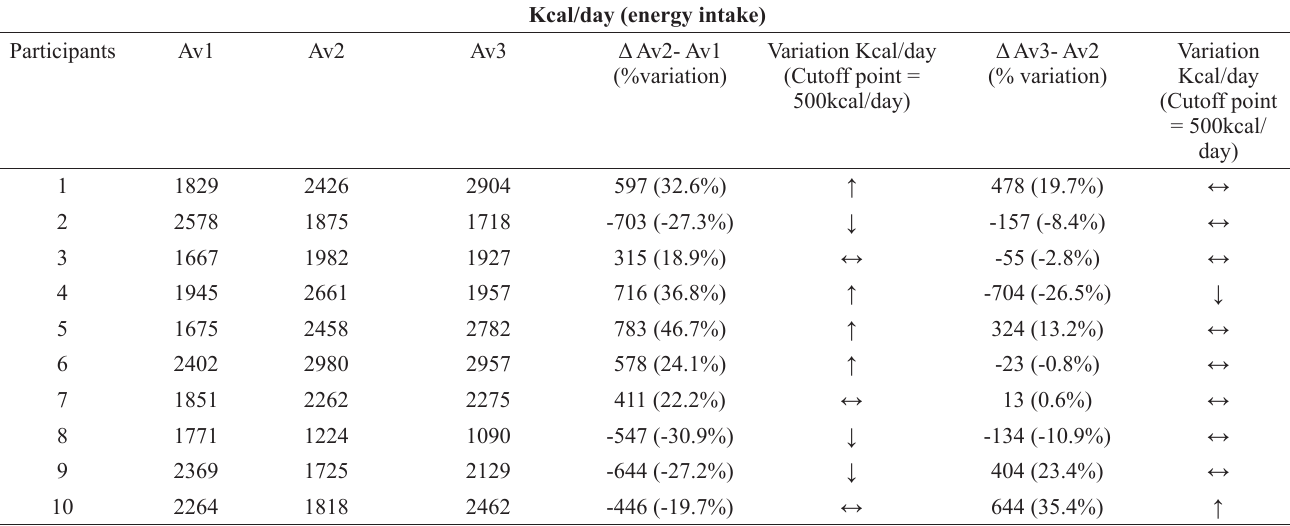
Table 3. Individual analysis of energy intake at each evaluated period and their variation between these periods.